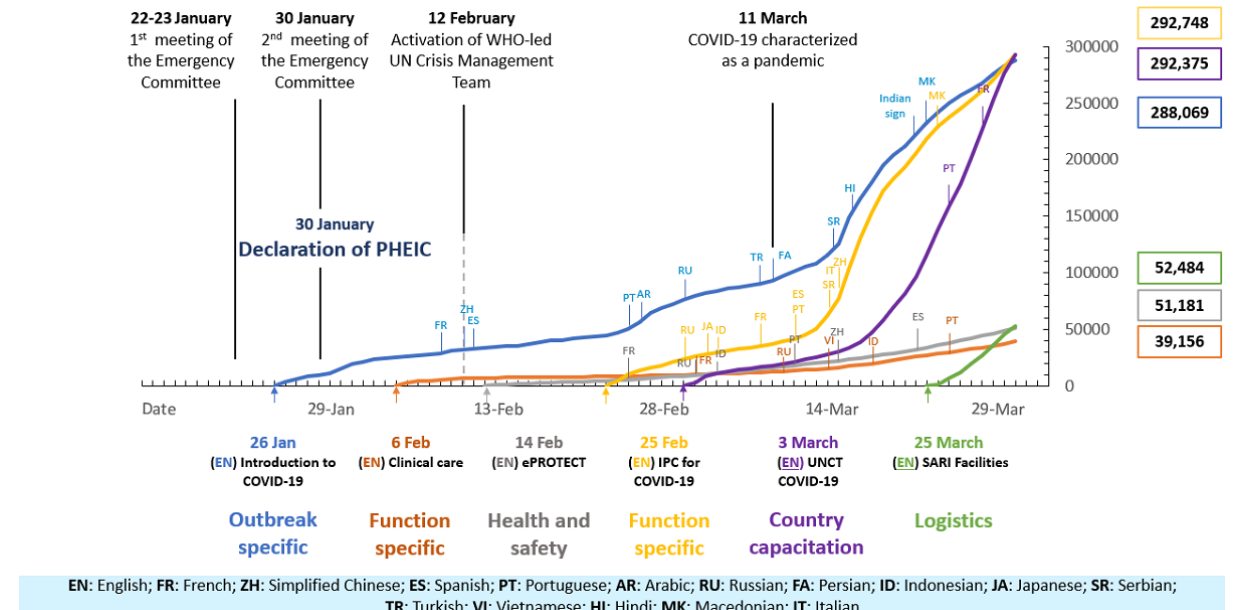
Figure 10. Timeline of all OpenWHO.org COVID-19 courses' launch and use. COVID-19: coronavirus disease; IPC: infection prevention and control; PHEIC: Public Health Emergency of International Concern; SARI: severe acute respiratory infection; UNCT: UN country teams; WHO: World Health